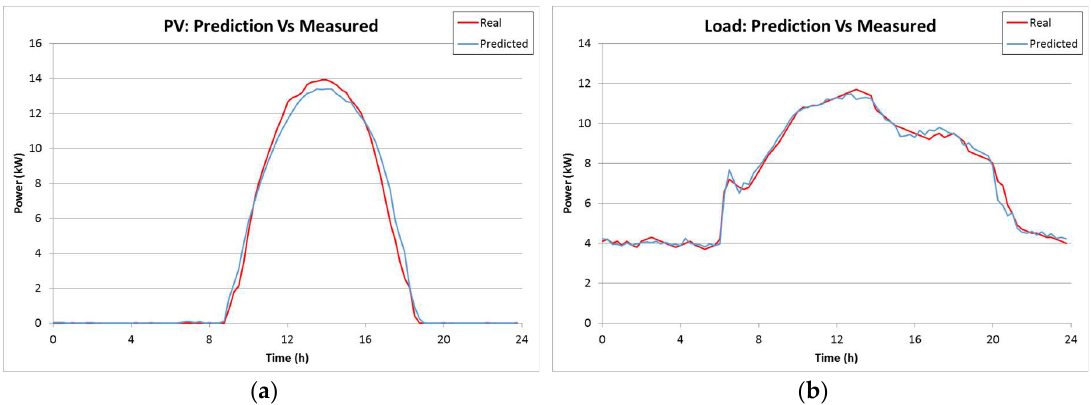
Figure 9. Predictions and actual values for ( a ) the PV generation and ( b ) the loads.